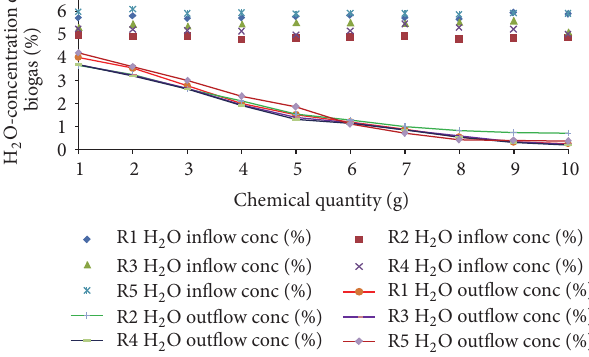
Figure 4: H 2 O inflow versus outflow concentration of biogas under the treatments of runs R1, R2, R3, R4, and